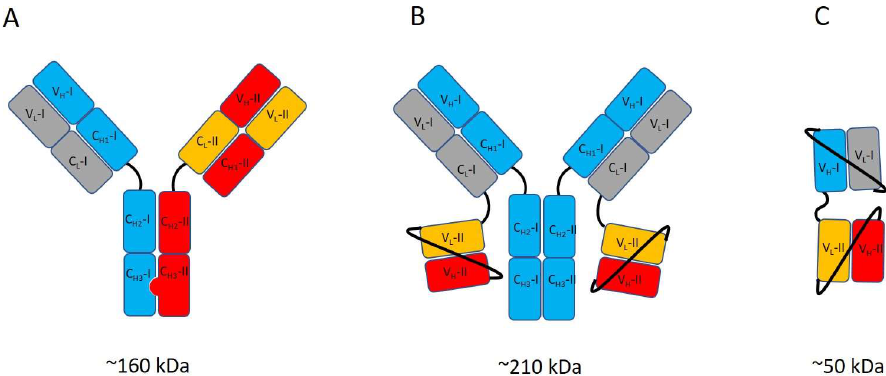
Figure 1. Examples of bispecific antibody constructs. ( A ) IgG-like asymmetric antibody engineered to bind an RMT-associated target with one of its binding arms and the CNS-associated target with the other binding arm. The knob-into-hole approach [41] is used to guide correct pairing of two different heavy chains, and CrossMab technology [42] is used to prevent mispairing of the light chains. ( B ) IgG-like antibody with scFv fragments of different binding specificity conjugated to the C-terminus of the light chains. This is a symmetric IgG-based construct. ( C ) di-scFv construct in which two scFvs with different binding specificities are fused together via a short peptide linker. V L and V C refer to the light chain variable and constant domains, respectively. V H , C H1 , C H2 and C H3 refer to the heavy chain variable domain and the constant domains 1, 2 and 3, respectively. The roman numbers in the domain names (e.g., V L -I or V L -II) show which of the two different binding specificities the domain is associated